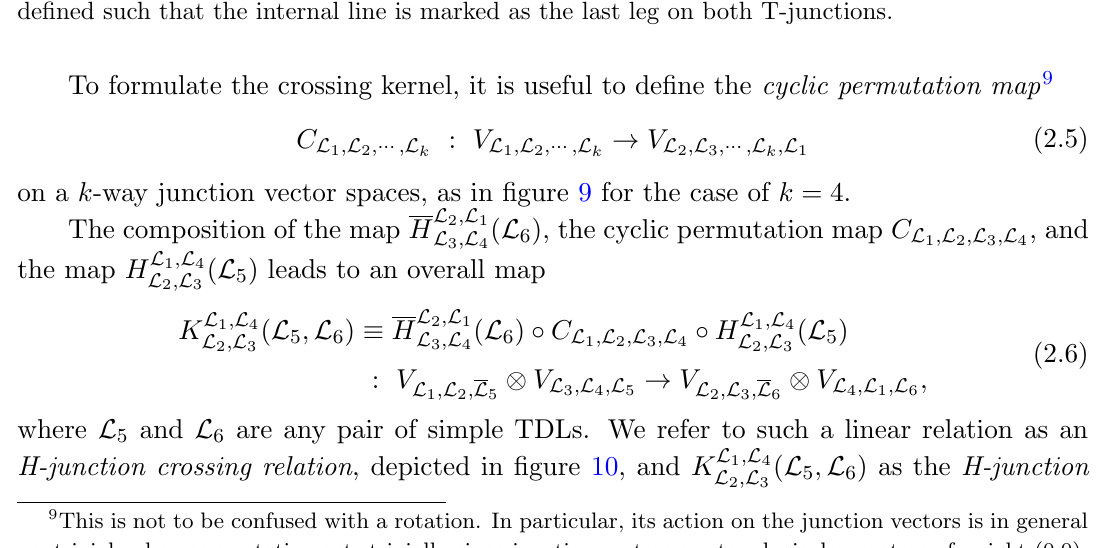
( L 5 ; L 6 ) L 2 ; L 3